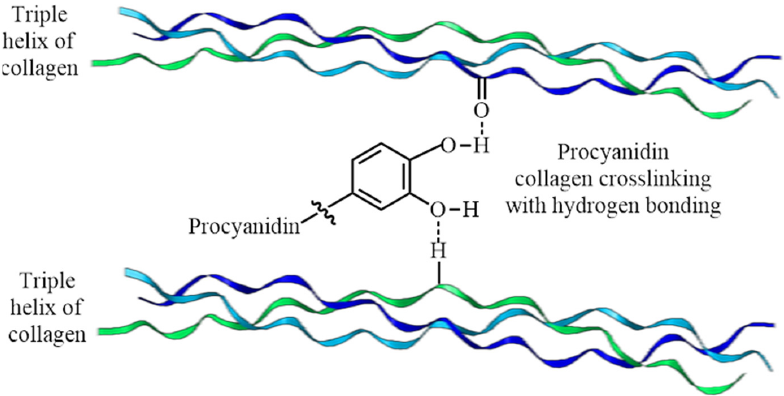
Figure 4. Illustration of collagen triple helix structure (PDB ID: 1BKV) crosslinked with procyanidins by hydrogen bond formation.